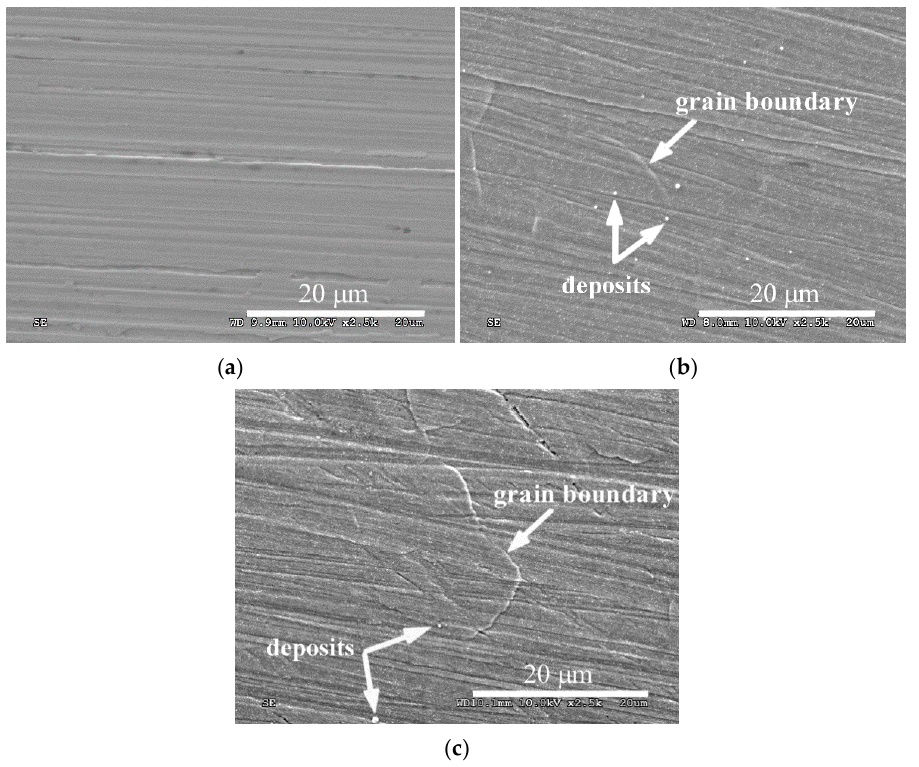
Figure 3. Surface morphology of AISI 316L steel in its initial state ( a ) and of ASPN ( b ) and ASPNC ( c ) layers.